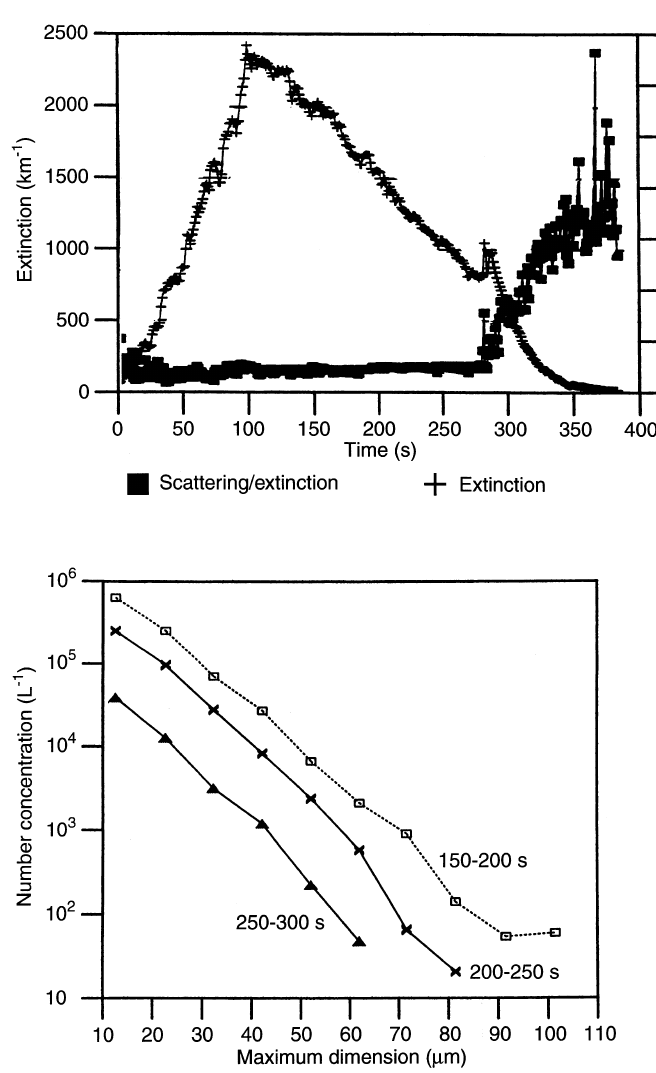
Fig. 5. Ice crystal size distributions for a dissipating cloud at ) 15 (cid:176) C